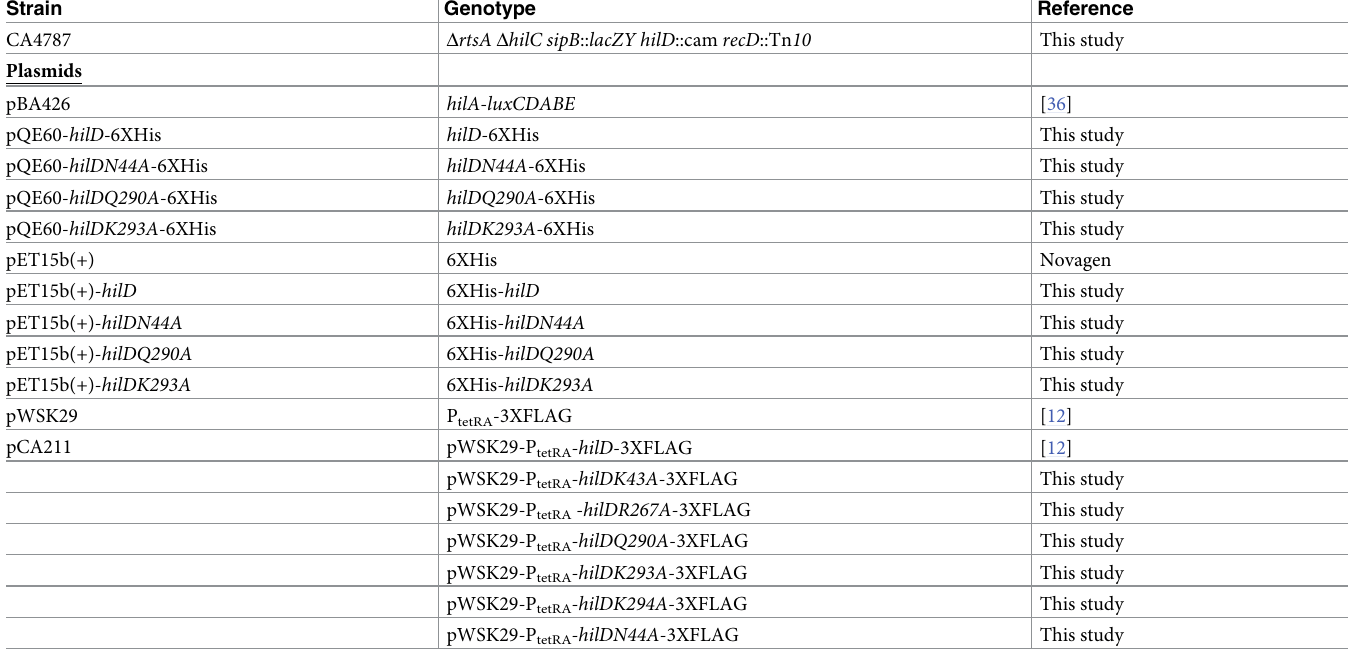
Table 1. Strains and plasmids used in the